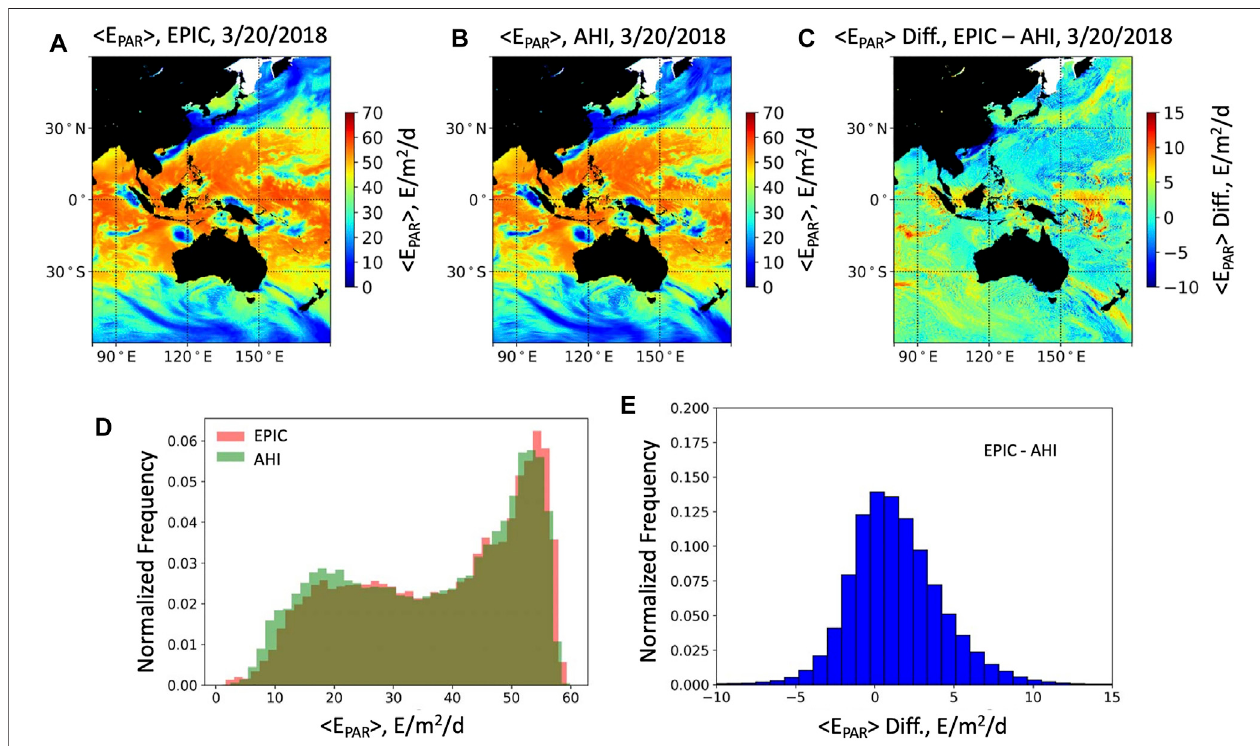
FIGURE10|(A) < E PAR > derivedfromEPICimageryofMarch,20,2018; (B) sameas (A) ,butAHIimagery; (C) mapofthedifferencebetweenEPICandAHI < E PAR > estimates; (D) histogram of the EPIC and AHI < E PAR > values; (E) histogram of the difference between EPIC and AHI < E PAR > estimates.